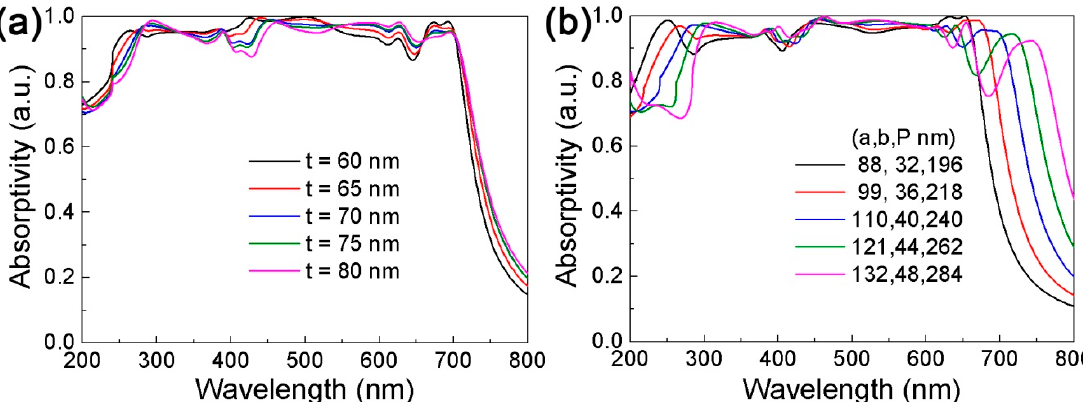
Figure 6. The influence of changing the thickness and period of the resonator in the wavelength range. ( a ) The absorption evolution of the resonator thickness from 60 nm to 80 nm; ( b ) in the absorption evolution under different periods, the ratio coefficient between the semi-major axis and the semi-minor axis is set as 2.75, which is consistent with the initial proportionality coefficient.